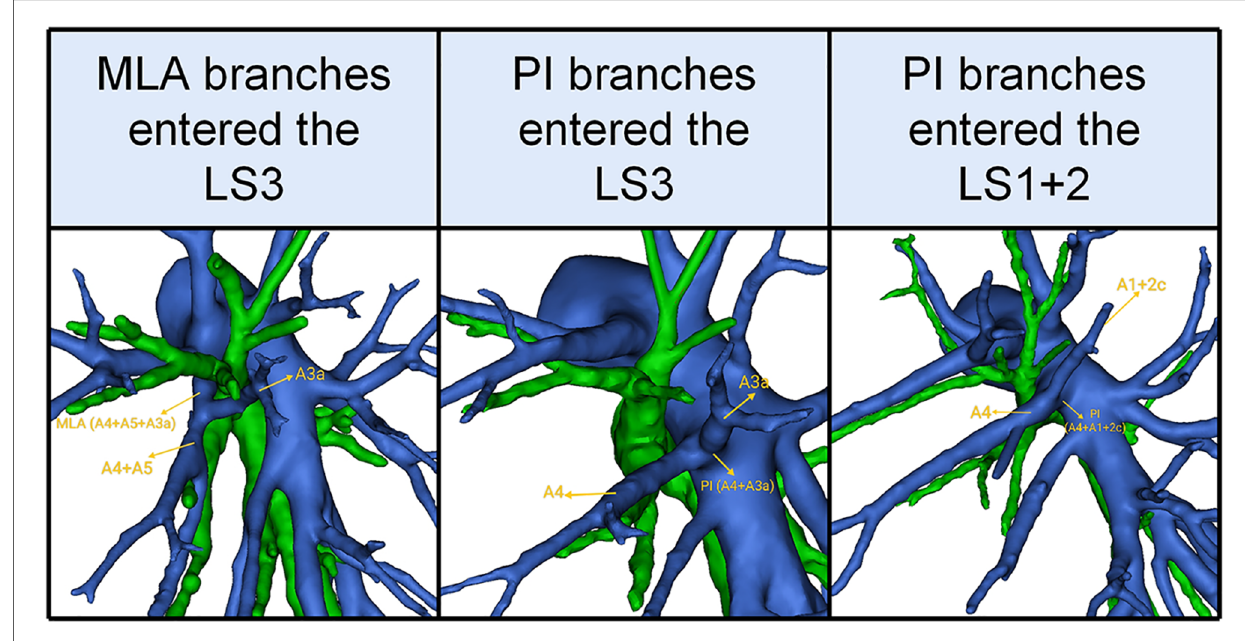
FIGURE 5 3D reconstruction model of the branches of the lingular segment artery entered the LS1+2 and